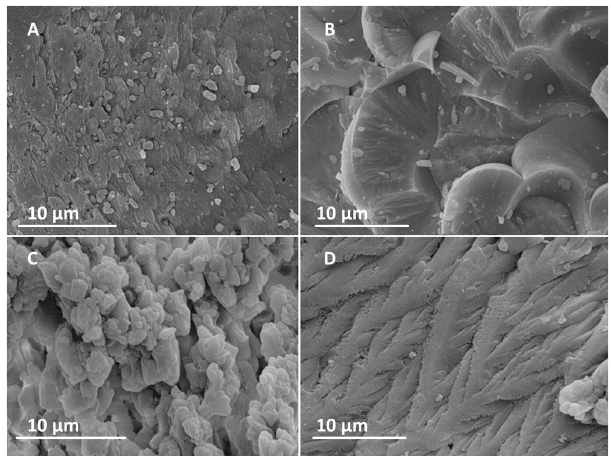
Figure 7. X-ray diffraction pattern of crystals from the laboratory experiments. The minerals that grew at 23 ◦ C show a pure vaterite signal. Similarly, minerals formed at 50 and 70 ◦ C yield an al- most pure vaterite signal with a non-quantifiable fraction of calcite (traces, ≤ few %). The samples at 37 and 91 ◦ C contain a minor fraction of calcite and aragonite ( ≤ 6% in